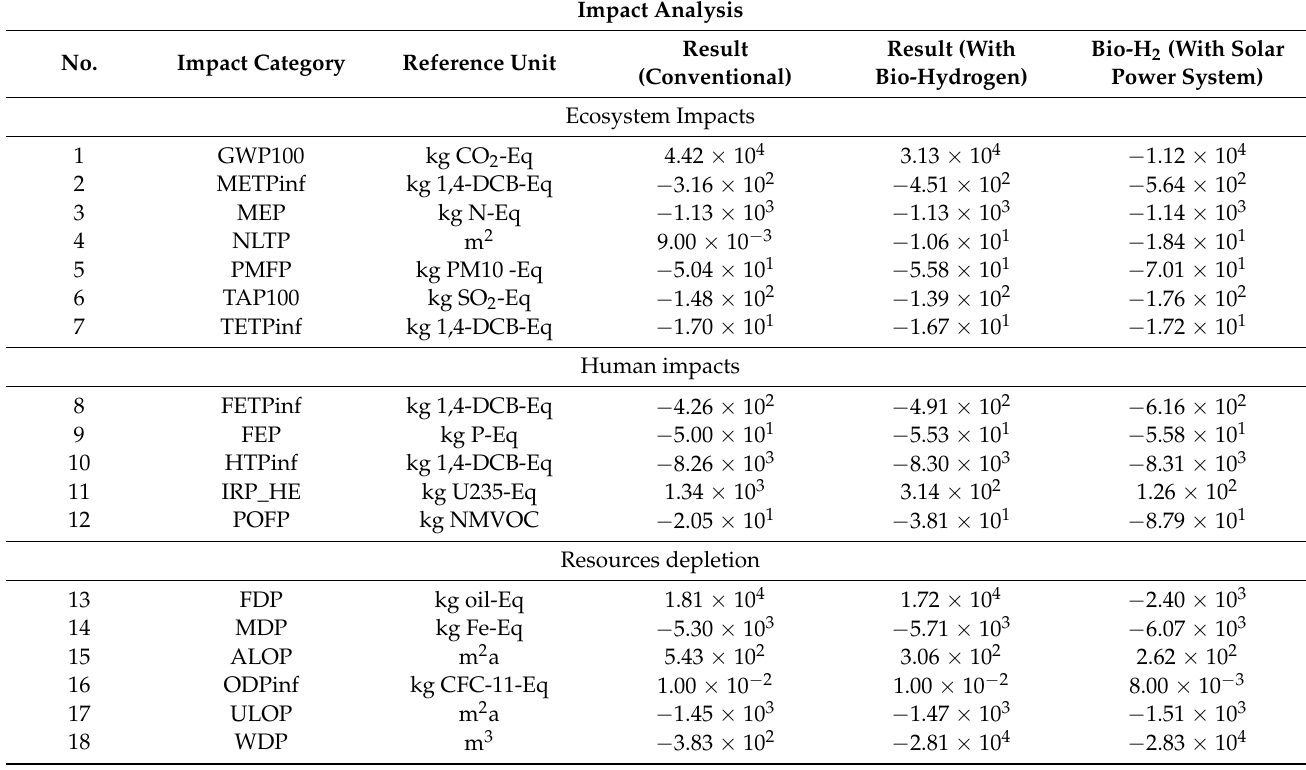
Table 11. Comparison of the LCIA with/without solar